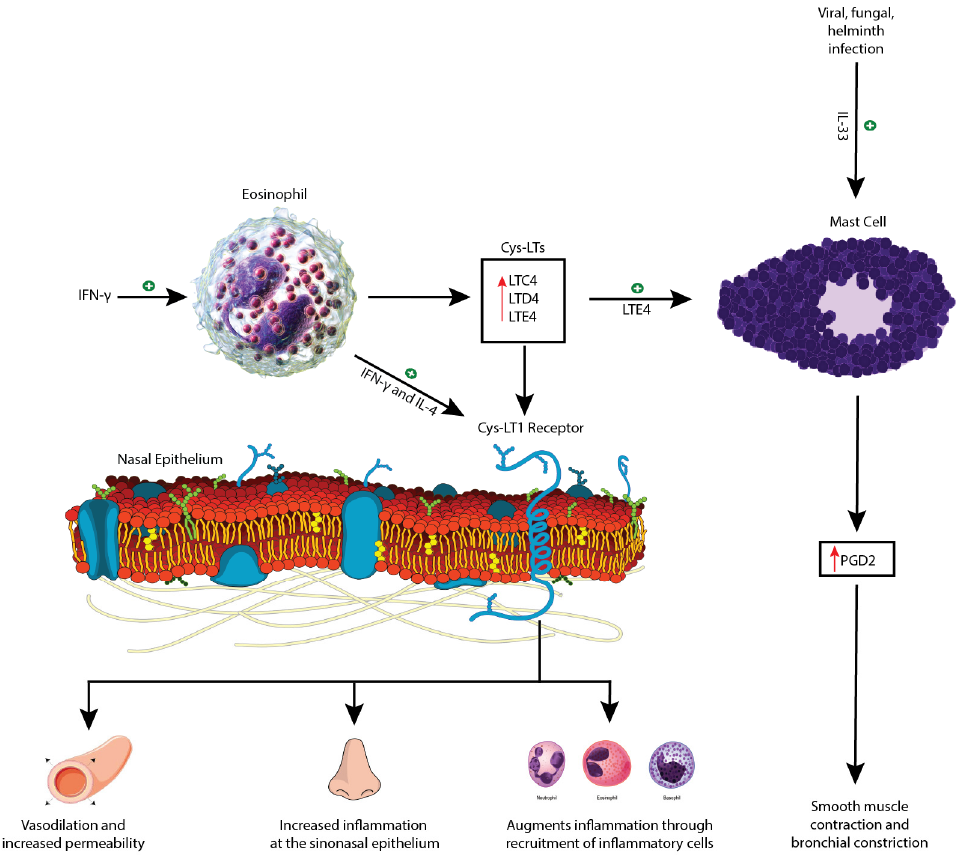
Figure 2. Schematic diagram depicting the role of Cys-LT1 activation and mast cell activation in pathogenesis of aspirin exacerbated respiratory disease (AERD) symptoms. INF- γ – interferon- gamma; IL-4 – interleukin-4; Cys-LT – cysteinyl-leukotriene; Cys-LT1 – cysteinyl-leukotriene 1; LTC4 – leukotriene C4; LTD4 – leukotriene D4; LTE4 – leukotriene E4; IL-33 – interleukin-33; PGD2 – prostaglandin D2. This figure incorporates free publicly available images [41–44] .